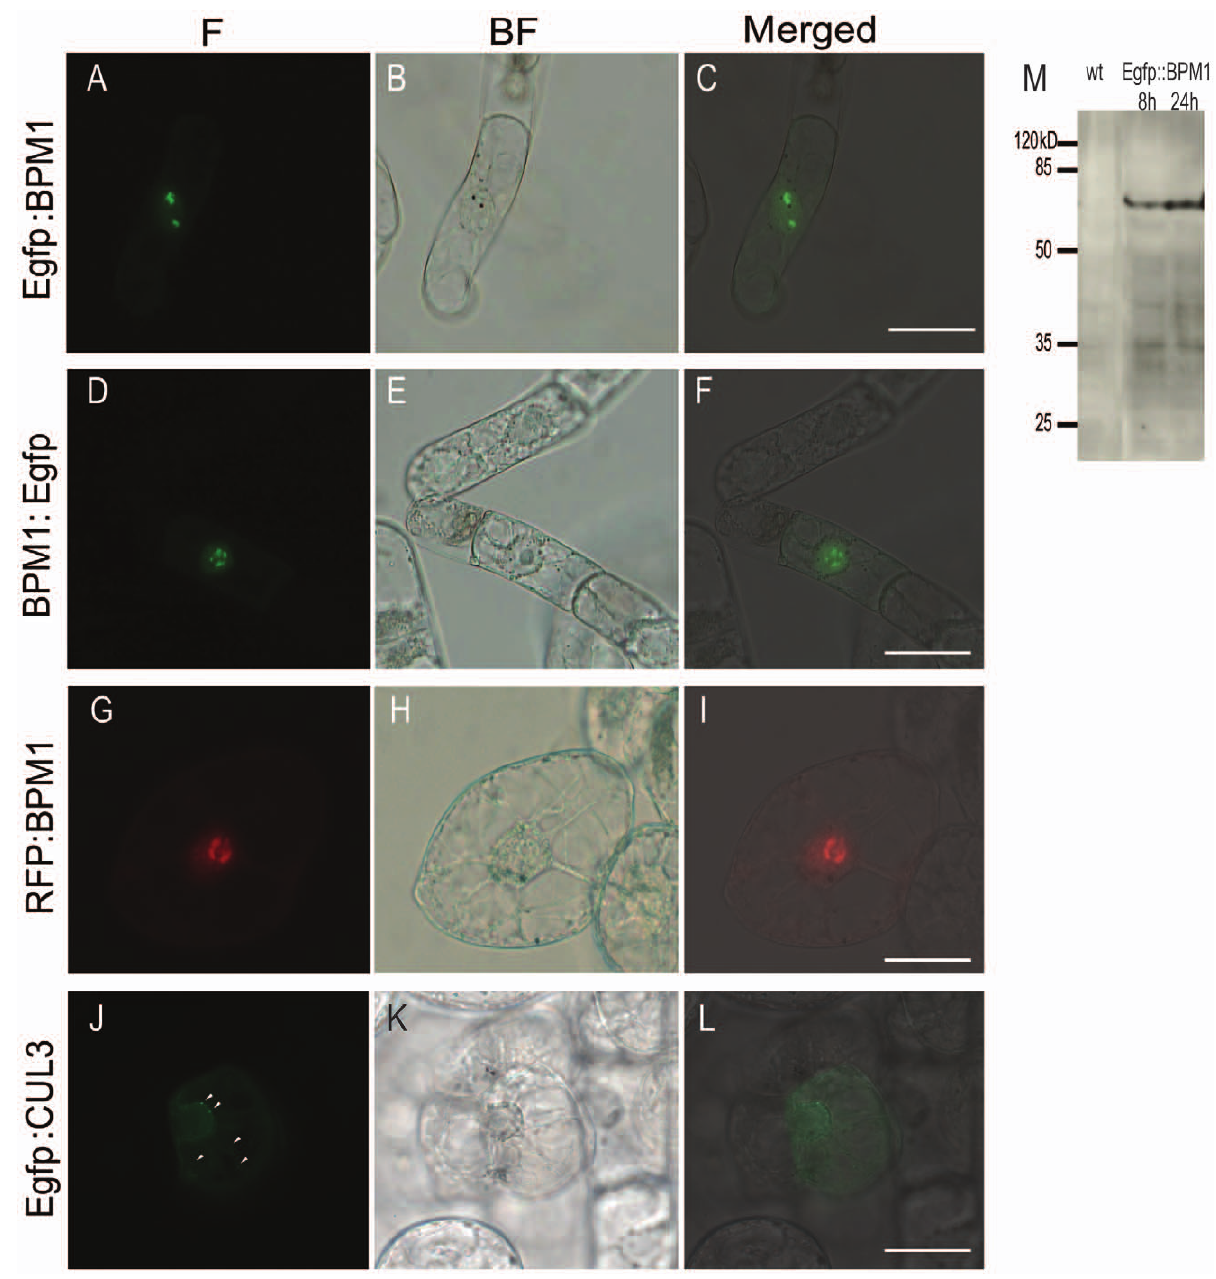
Figure 1. Subcellular localization of BPM1 and CUL3 proteins in the tobacco BY2 cells. Intact BPM1 protein (Egfp:BPM1, BPM1:Egfp and RFP:BPM1) is dispersed throughout the cytoplasm, forming agglomerates in the nucleus (A–I). CUL3 is dispersed in both the cytoplasm and the nucleus, additionally forming cytoplasmic speckles (arrowhead) (J–L). M: Detection of the complete Egfp:BPM1 protein (73 kD) from BY2 cells by western blot analysis, 8 and 24 hours after biolistic transformation. Images shown are bright field (BF), Egfp and RFP fluorescence (F), and a merged image. Bars are 50 m m. doi:10.1371/journal.pone.0051184.g001 separately, considering the whole cell, as well as the nucleus and RFP:BPM1 and Egfp:CUL3 resulted in protein co-localization nucleolus in particular. Statistical analysis of measured Pearson’s both in the cytoplasm, along cytoplasmic strands, and in the coefficient (PC) values clearly demonstrated the highest co- nucleus. However, CUL3 signals were weak and dispersed localization when the whole cell was considered (Fig. 4B), sporadically with small bright dots in cytoplasm, whereas BPM1 reflecting even distribution of both proteins mostly in the signals reflected distinguishable agglomerates in and around the cytoplasm. Interestingly, significantly lower mean PC values were nucleolus (Fig. 1J–L, Fig. 4A). To investigate CUL3 and BPM1 obtained by analyzing the nucleus and the nucleolus, the latter protein co-localization in different cellular compartments three- being devoid of CUL3 to a large extent (Fig 4B). dimensional space stacks of deconvolved images were analyzed